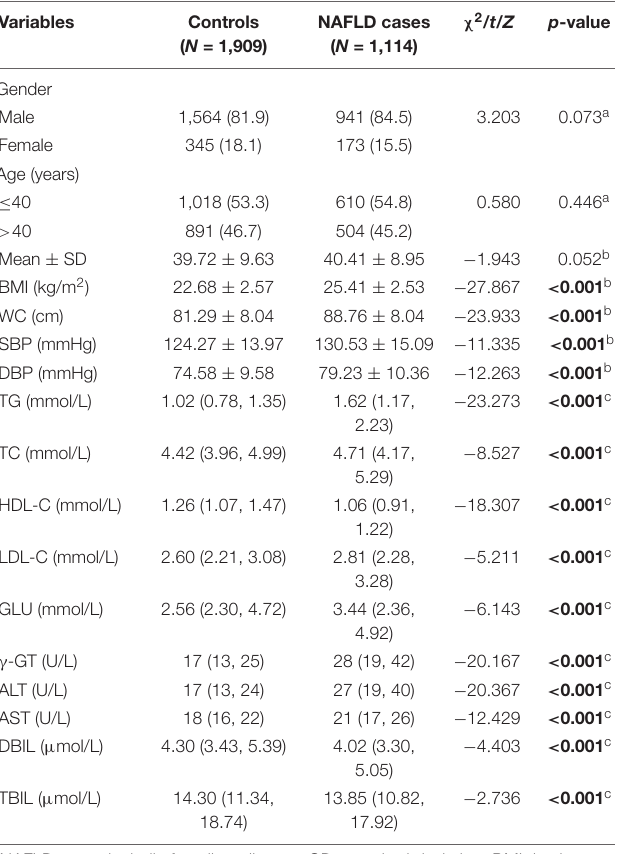
TABLE 1 | Distributions and comparisons of demographic and clinical characteristics between NAFLD case and control groups.